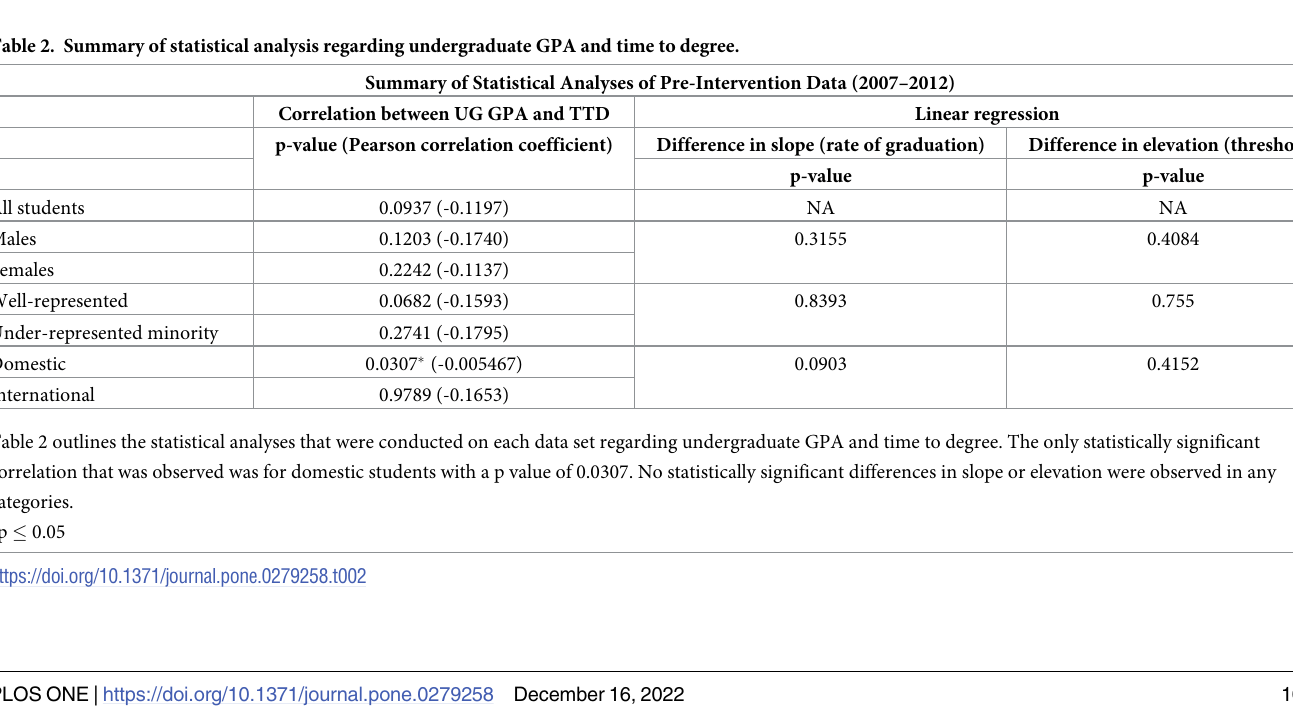
Table 2. Summary of statistical analysis regarding undergraduate GPA and time to degree.